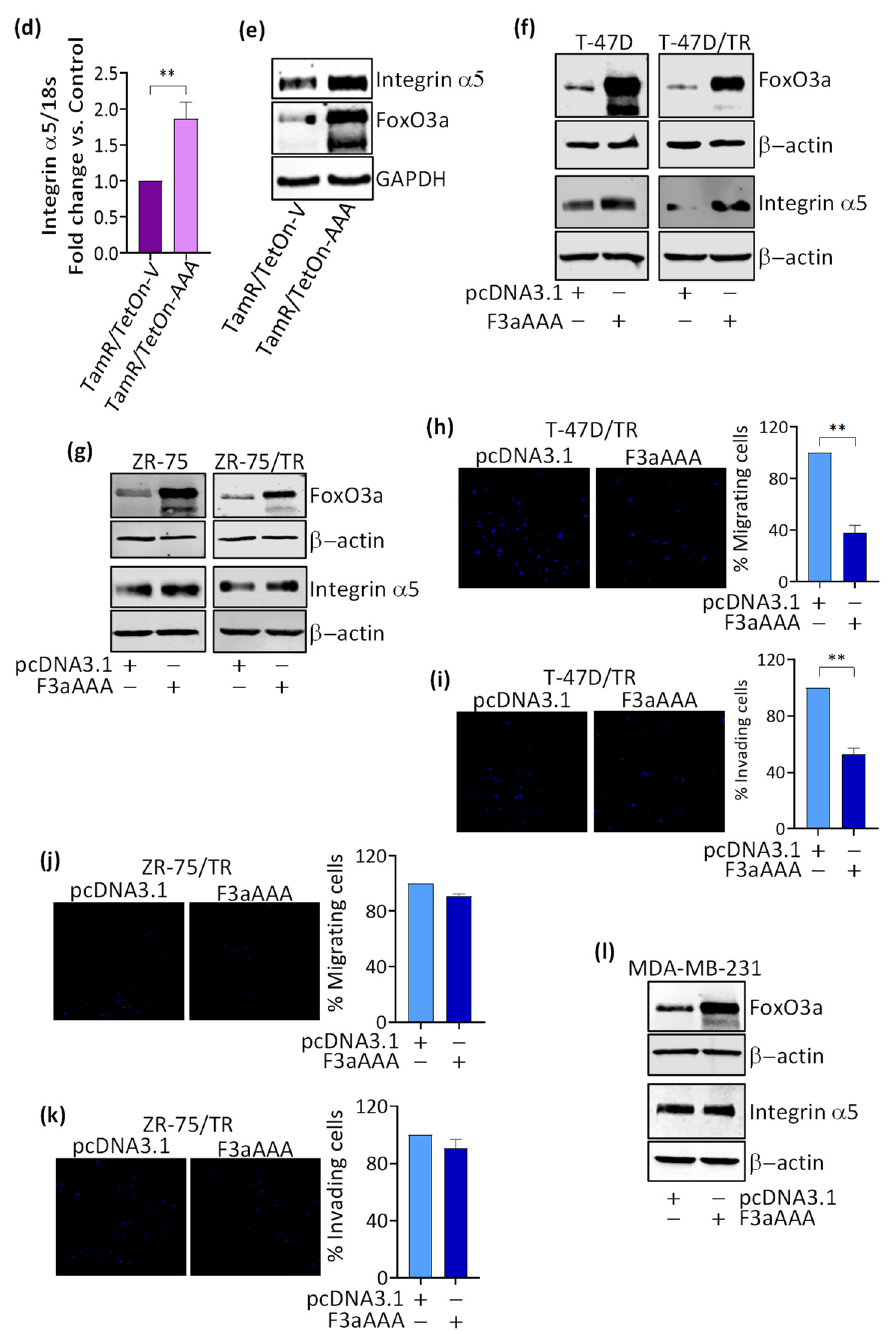
Figure A2. FoxO3a induces integrin α 5 expression in ER α + but not in ER α − BCCs. WB analysis of ( a ) T-47D, ( b ) ZR-75 and their tamoxifen-resistant-derived cells (T-47D/TR and ZR-75/TR, respectively), showing a much lower expression of FoxO3a and integrin α 5 in resistant cell lines, compared to parental cells. ( c ) Total proteins were extracted from TamR/TetOn-AAA and from TamR/TetOn- V control-derived tumors, previously explanted from Dox-treated mice [9], and subjected to WB analysis to evaluate β 1 expression ( β -Actin: loading control). Dox-induced FoxO3a (for 48 h) increased integrin α 5 mRNA ( d ) and protein ( e ) content in TamR/TetOn-AAA cells but not in control TamR/TetOn-V cells. A higher protein expression of integrin α 5 was observed in the other two FoxO3a overexpressing, ER α + BC cell lines, ( f ) T-47D and ( g ) ZR-75 as well as in their tamoxifen- resistant counterparts. FoxO3a ectopic expression also affected T-47D ( h , i ) and, in a lesser extent, ZR-75 ( j , k ) motility and invasiveness. All the experiments conducted on T-47D, ZR-75, and